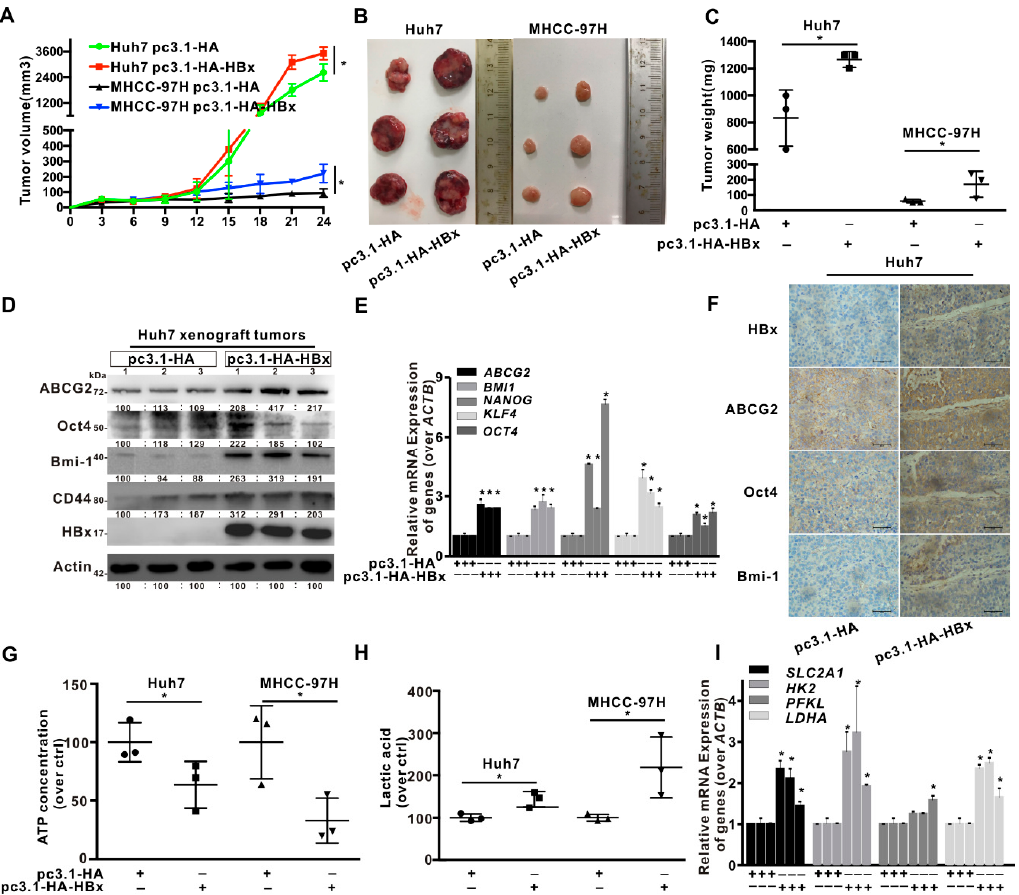
Figure 1. HBV x protein (HBx) promoted the hepatocellular carcinoma (HCC) xenograft tumors growth via the upregulat ion of glycolytic metabolism in vivo. The HCC xenograft tumors with or without HBx-expressing were formed by Huh7-/MHCC-97H-pcDNA3.1-HA-HBx or Huh7-/MHCC- 97H-pcDNA3.1-HA cells in BALB/c nude mice for 24 days. n = 6. ( A ) The growth curves of tumors were measured every two days. ( B ) Excised tumors were photographed after mice were sacrificed. ( C ) Tumor weights in the four groups. ( D ) The expression level of the cancer stemness